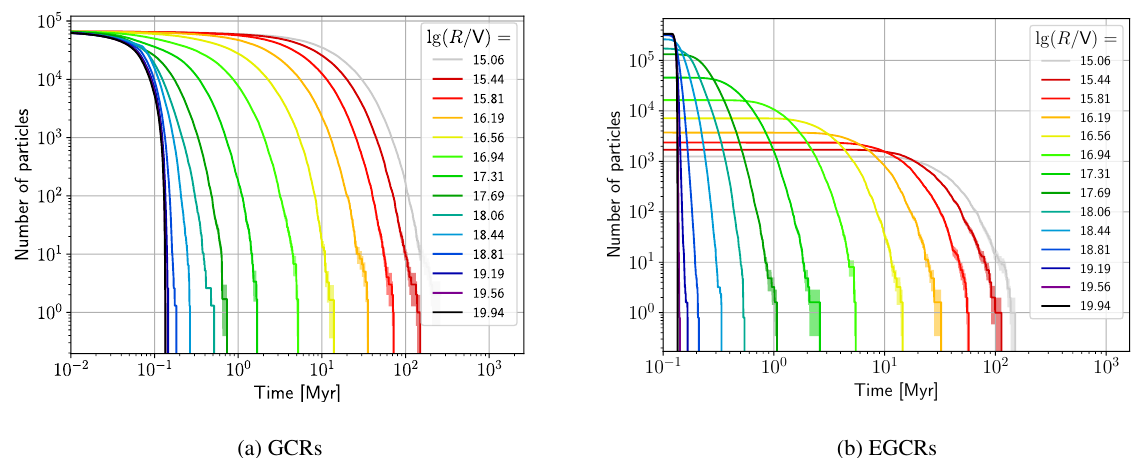
Figure 2: Evolution of the CR count in the GP for several rigidity bins indicated in legend (from [8]).